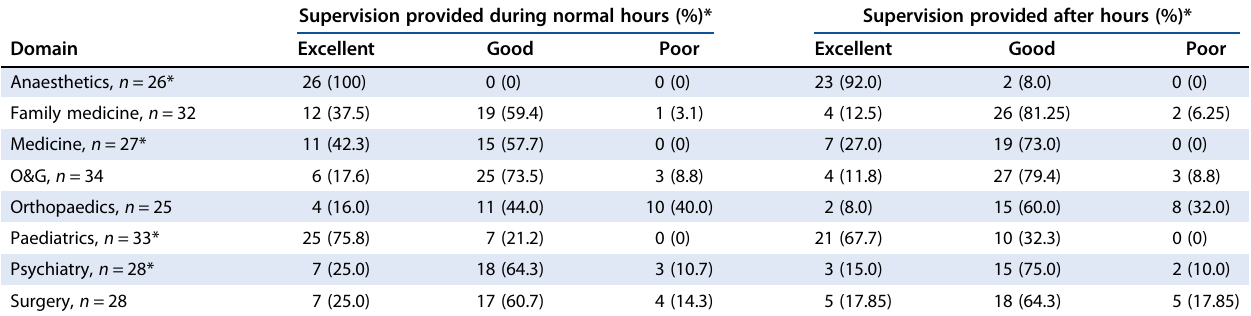
Table 1: Supervision of interns during normal hours and after hours at KEH